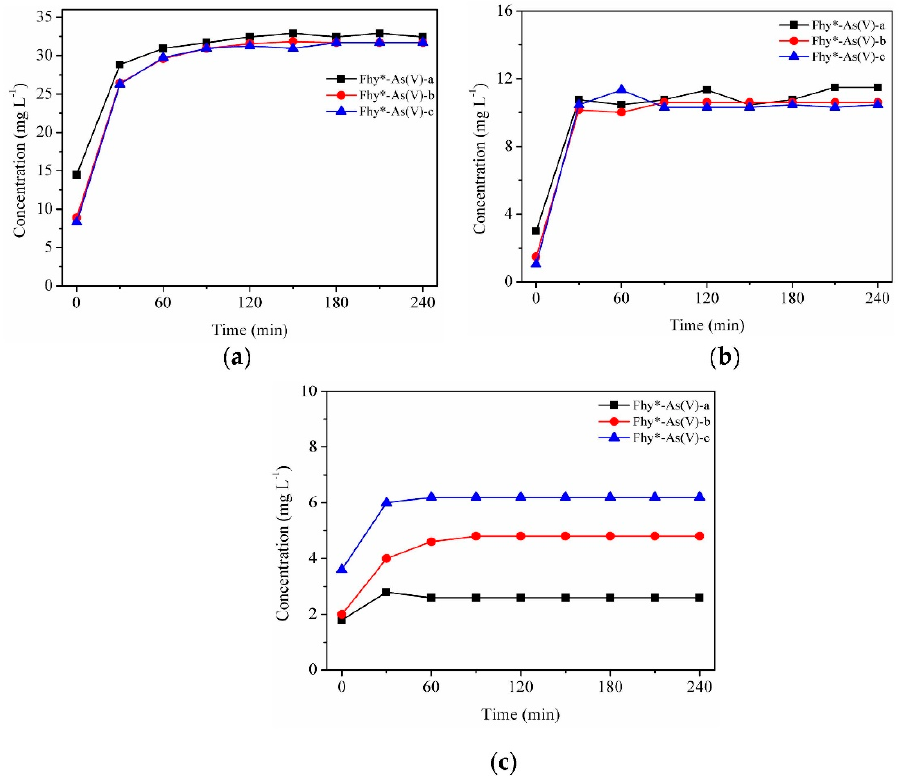
Figure 7. Dissolution kinetics in the dark with suspensions of 0.1 g L − 1 Fhy*-As(V) at pH 3.0 with 1.0 mM oxalic acid. Dissolved TFe ( a ), dissolved Fe(II) ( b ), and As(V) ( c ) were measured.